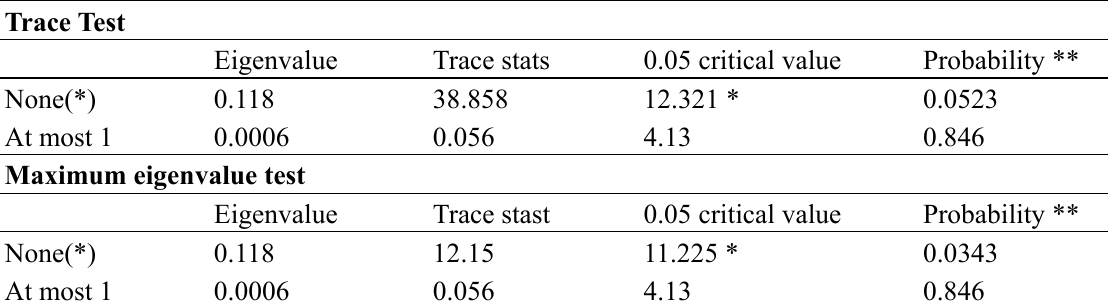
Table 4. Trace test and eigenvalue test.